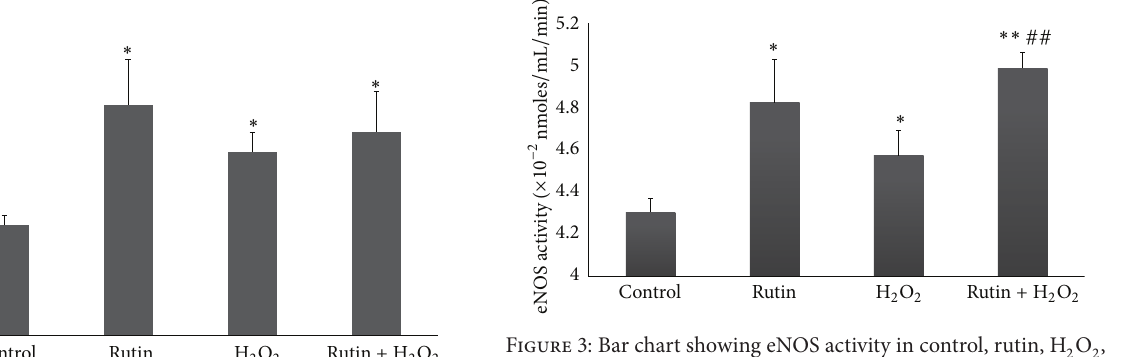
Figure 3: Bar chart showing eNOS activity in control, rutin, H 2 O 2 , and rutin + H 2 O 2 groups. Values are expressed as means ± SEM of 𝑛 = 8 . ∗ 𝑃 < 0.05 versus control; ∗∗ 𝑃 < 0.01 versus control; and ## 𝑃 < 0.01 versus H 2 O 2 .